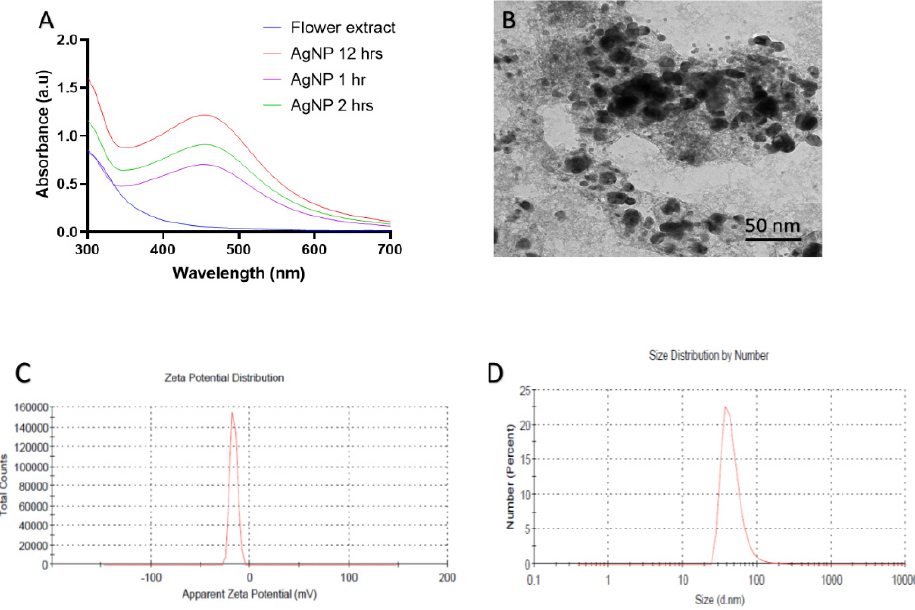
Figure 1. Physical characterization of the synthesized B-AgNPs. ( A ) UV–visible absorption spectra of B-AgNPs synthesized using Rosa petal extract: UV-Vis spectra of silver nanoparticles generated when AgNO 3 (1 mM) was incubated with Rosa Santana petal extract. As the petal extract are added to the incubation mixture, the distinctive surface plasmon resonance (SPR) bands corresponding to silver nanoparticles gradually shift toward longer wavelengths with associated band intensity am- plification. ( B ) TEM study of as-synthesized B-AgNPs reveals their shape and size: A representative TEM picture of silver nanoparticles generated from Rosa Santana petal extract. TEM micrograph demonstrating the coexistence of spherical and oval nanostructures of B-AgNPs formed during the incubation of Rosa Santana petal extract in aqueous AgNO 3 . ( C ) Zeta potential of the synthesized B- AgNPs. ( D ) Size study of the B-AgNPs using DLS (Dynamic Light Scattering): indicates that the as- synthesized silver nanoparticles have an overall particle radius of around 10–50 nm.